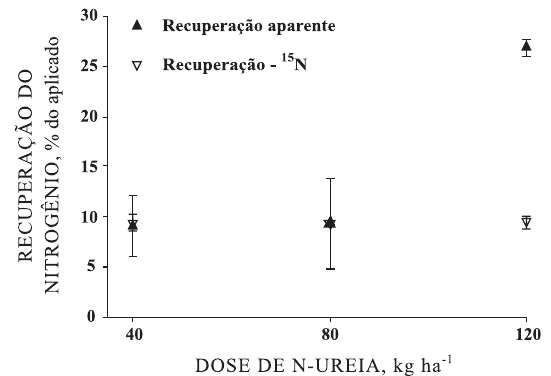
Figura 5. Estimativa da recuperação percentual do nitrogênio aplicado na parte aérea de capim- tanzânia adubado, com 40, 80 e 120 kg ha -1 de 15 N-ureia, pelos métodos aparente e isotópico. As barras verticais indicam o erro-padrão da